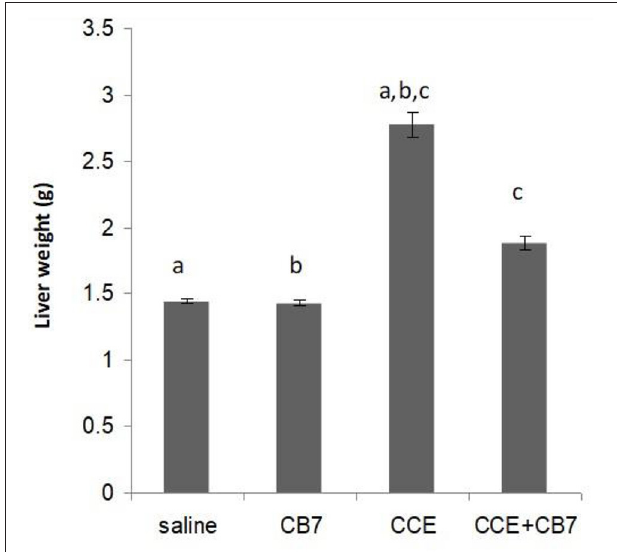
FIGURE 2 | Effects of cucurbit[7]uril (CB7) on cyanobacterial crude extract (CCE)-induced liver damage. Mice were divided into groups 1–4 and the livers from mice in each group were weighed. Data are presented as mean ± SEM. Bars with similar letters represent statistically significant differences. Ten mice per group ( n = 10).